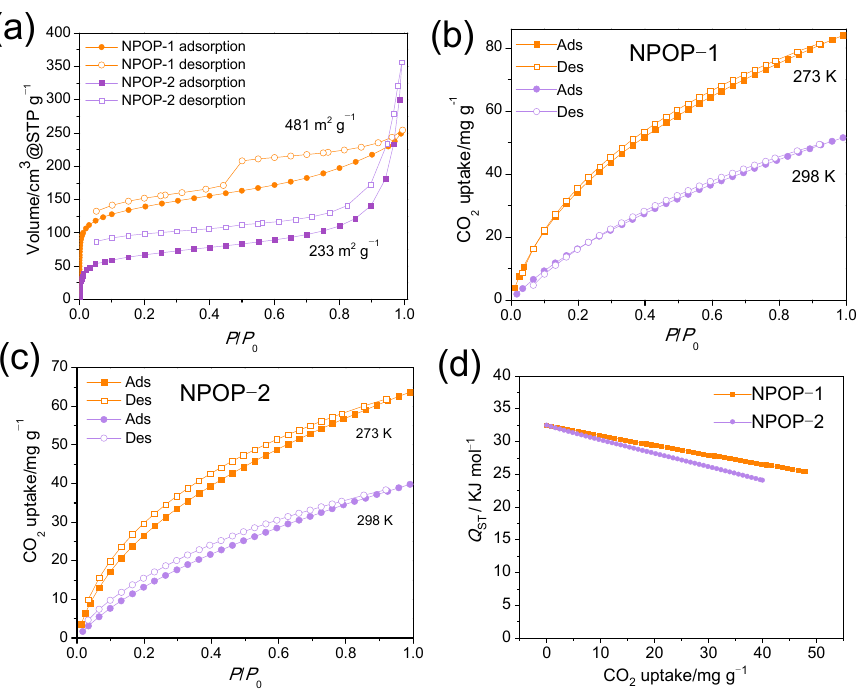
Figure 6. ( a ) N 2 adsorption–desorption isotherms of NPOP-1 and NPOP-2 at 77 K. CO 2 adsorption– desorption isotherms, at 273 K and 298 K, of: ( b ) NPOP-1, ( c ) NPOP-2, and (d) isosteric heats of CO 2 adsorption of NPOP-1 and NPOP-2 calculated with the virial method.